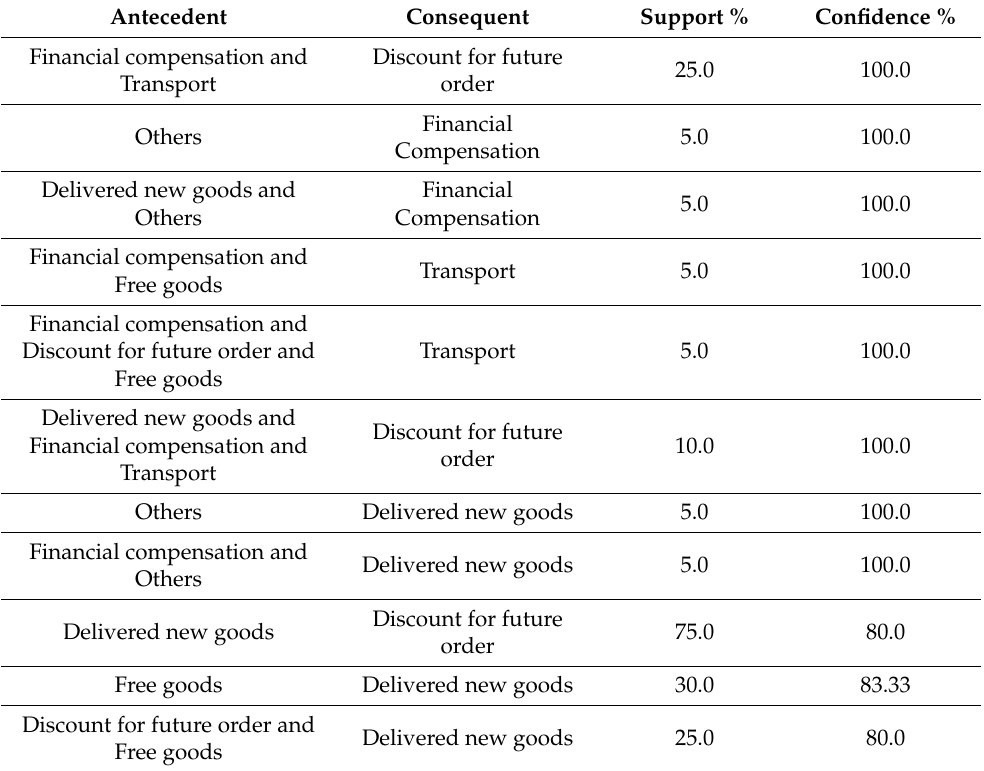
Table 6. Association rules of different types of compensation.